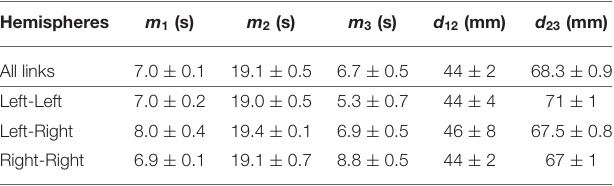
TABLE 2 | Results of the characterization of the piecewise-linear relationship for four different